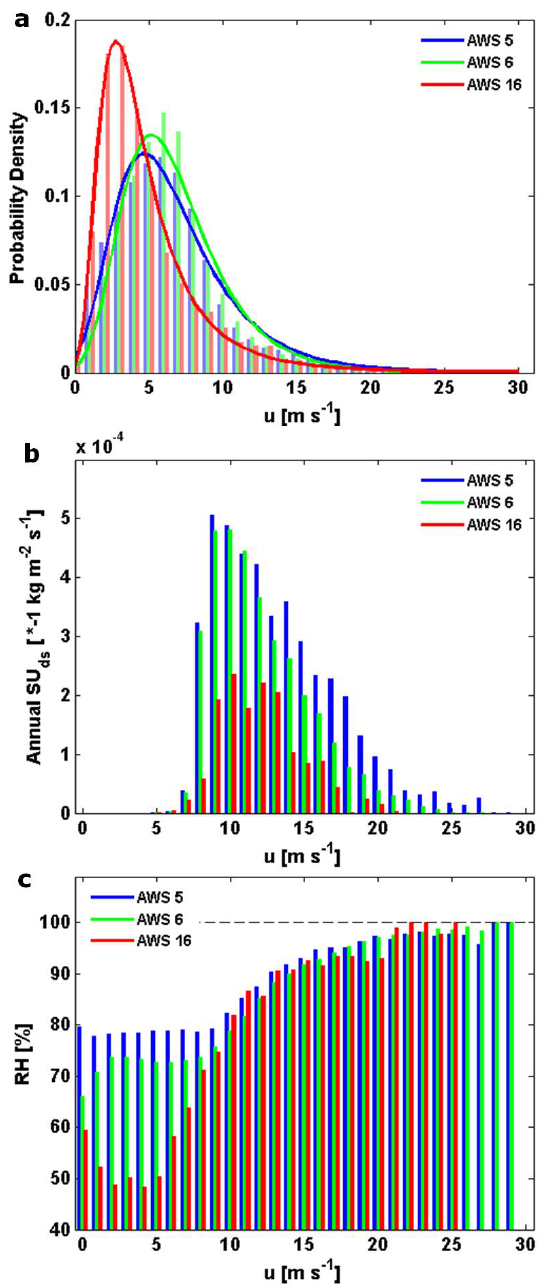
Fig. 11. (a) Histogram of 2-hourly mean wind velocity u , with the generalised extreme values (GEV) probability density function fit- ted to the data. From u > 25ms − 1 onwards, the three GEV curves overlay each other. Note that here the GEV distribution is preferred over the Weibull distribution, since R 2 is higher for the GEV fit (0 . 97 < R 2 < 0 . 99) than the Weibull fit (0 . 91 < R 2 < 0 . 95 ) at each location. (b) Total annual snowdrift sublimation SU ds for each wind speed bin (width = 1ms − 1 ) . (c) Mean relative humidity with re- spect to ice RH i for each wind speed bin (width=1ms − 1 )